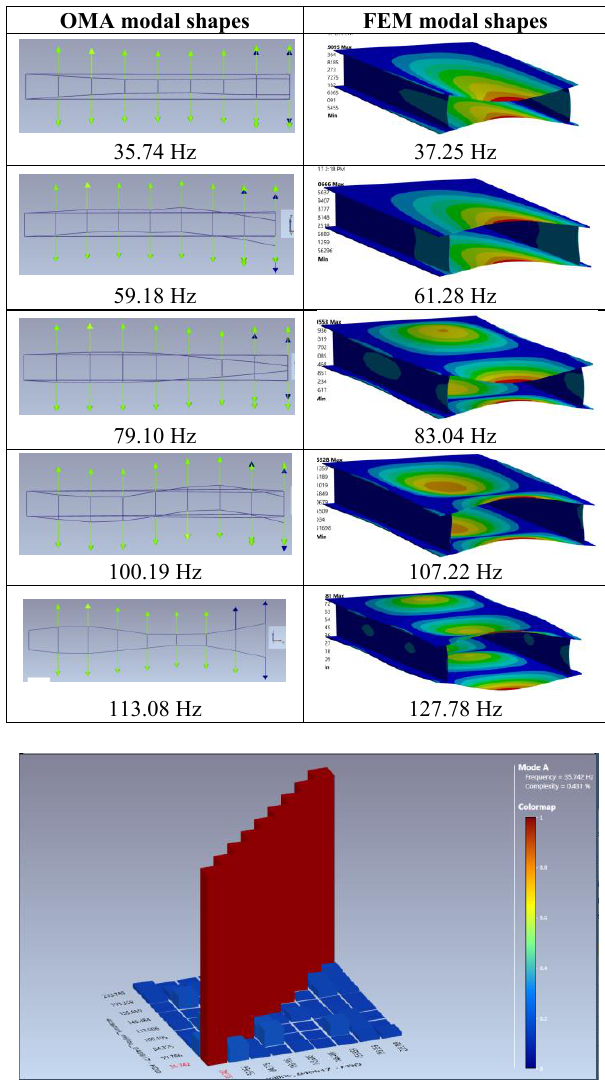
Fig. 8 Modal assurance criterion matrix